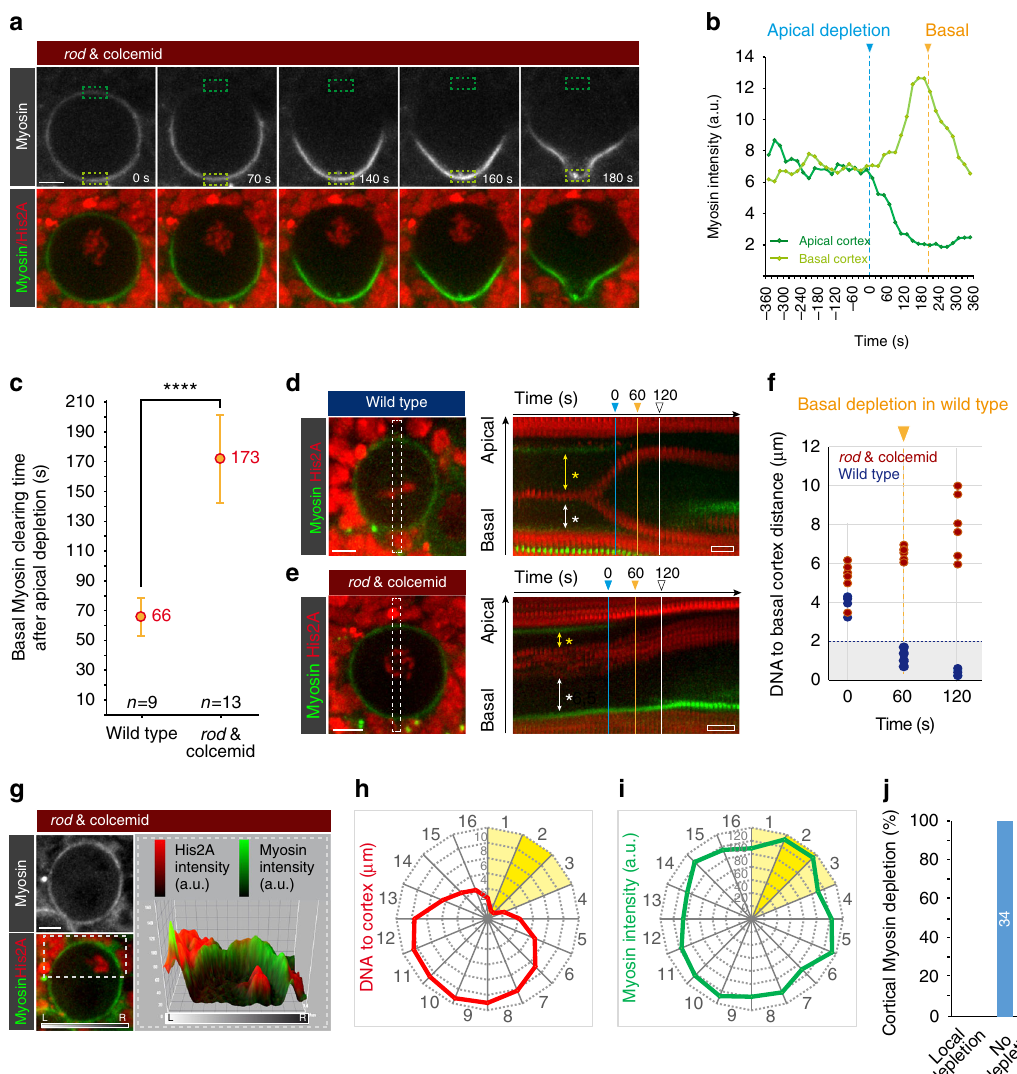
Fig. 3 Chromatid-derived cues are insuf fi cient to induce Myosin relocalization in fl y neuroblasts. a Representative image sequence showing a rod mutant neuroblast expressing Sqh::GFP (Myosin, top row; white, bottom row; green) and His2A::mRFP (DNA, bottom row; red) exposed to colcemid. Cortical Myosin intensity was measured at the apical and basal cortex, respectively (dark and light green dashed boxes) and plotted in ( b ). c Graph showing the mean and standard deviation of basal Myosin clearing in relation to apical depletion (timepoint “ 0 ” ) for wild-type and rod mutant, colcemid-treated neuroblasts. Kymographs obtained from wild-type ( d ) and rod mutant neuroblasts exposed to colcemid ( e ) showing Myosin (green) and DNA (red). The white dashed line indicates the region represented in the kymograph. Kymographs were used to measure the distance between the chromosomes and the apical (yellow arrows) or basal cortex (white arrows). f Scatter plot representing the distance between chromosomes and the basal cortex at the onset of apical Myosin depletion (0 s), at the onset of basal Myosin clearing (60 s) and once basal Myosin depletion is completed (120 s). g Representative rod mutant, colcemid-treated neuroblast expressing Sqh::GFP (white; top panel, green; merge) and His2A::mRFP (red). Myosin and His2A intensity are shown in the 3D graph, corresponding to the ROI represented by the white dashed box. Radar graphs show the distance of the neuroblast ’ s chromatid to the cortex ( h ) and Myosin intensity ( i ) for each of the 16 represented sectors. Yellow sectors represent areas with high DNA-cortex proximity. j Bar graph showing the percentage of rod mutant, colcemid treated neuroblasts displaying cortical Myosin depletion when the proximity of the DNA with the cortex is < 2 µ m. Center values and error bars represent the mean and standard deviation (s.d), respectively. Asterisks denote statistical signi fi cance, derived from unpaired t tests: * p ≤ 0.05, ** p ≤ 0.01, *** p ≤ 0.001, **** p ≤ 0.0001. Each measured cell (n) is represented with a dot in the scatter plots. For other graphs, the number of measured cells is indicated in the corresponding panels. For each experiment, the data were collected from at least 3 independent experiments. For each independent experiment, at least 5 larvae were dissected. Time: seconds (s). Scale bar: 5 µ m. Time scale bars (open white box): 57 s in ( d ) and 60 s in ( e ), respectively. n.s. not signi fi